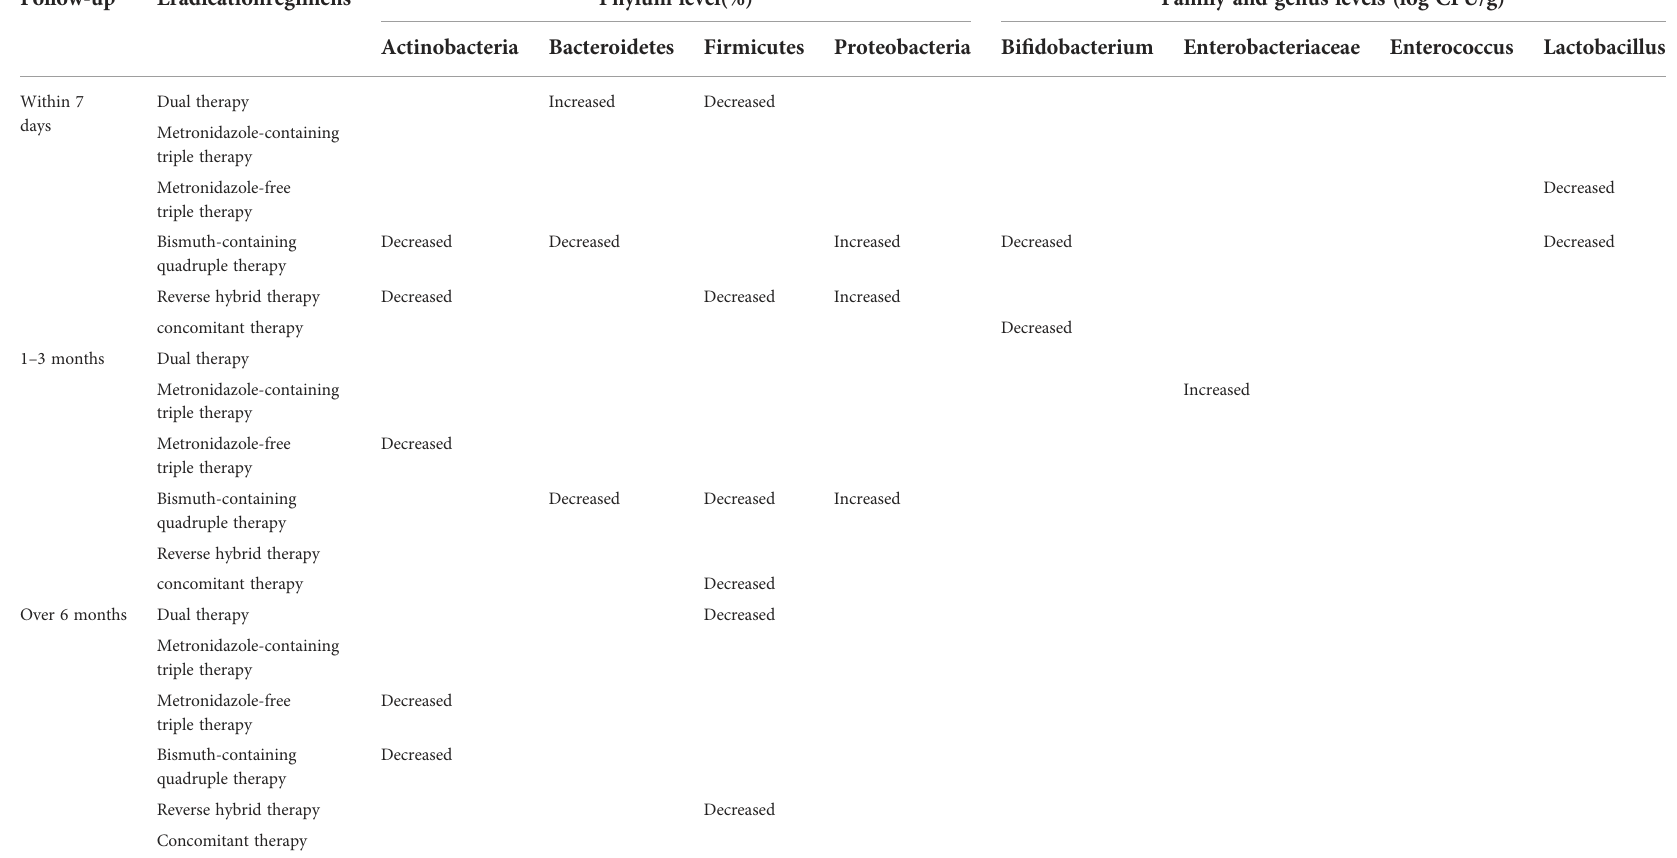
TABLE 1 Detailed list of gut microbiota